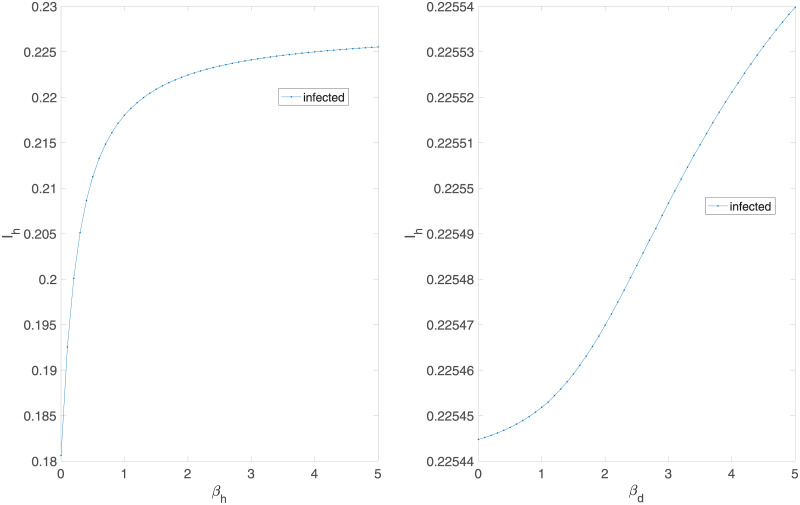
βh (right) and βd (left) are directly proportional to the proportion of humans infected with the mutated strain.